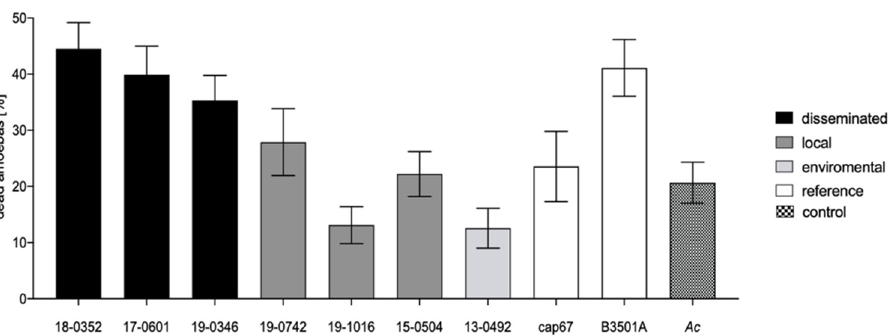
Figure 6. Cytotoxicity of C. neoformans var. neoformans isolates for A. castellanii after incubation in PBS medium at 29 °C for 48 h. Clinical isolates from disseminated infections (black) are more cytotoxic for amoebas than isolates from localized soft tissue infections (grey) and the environment (light grey). To define the range of this assay, a wild-type reference strain and an acapsular strain were included (white). A. castellanii was incubated without fungi as control (checkered). Standard deviations of three independent experiments with eight technical replicates each are shown.